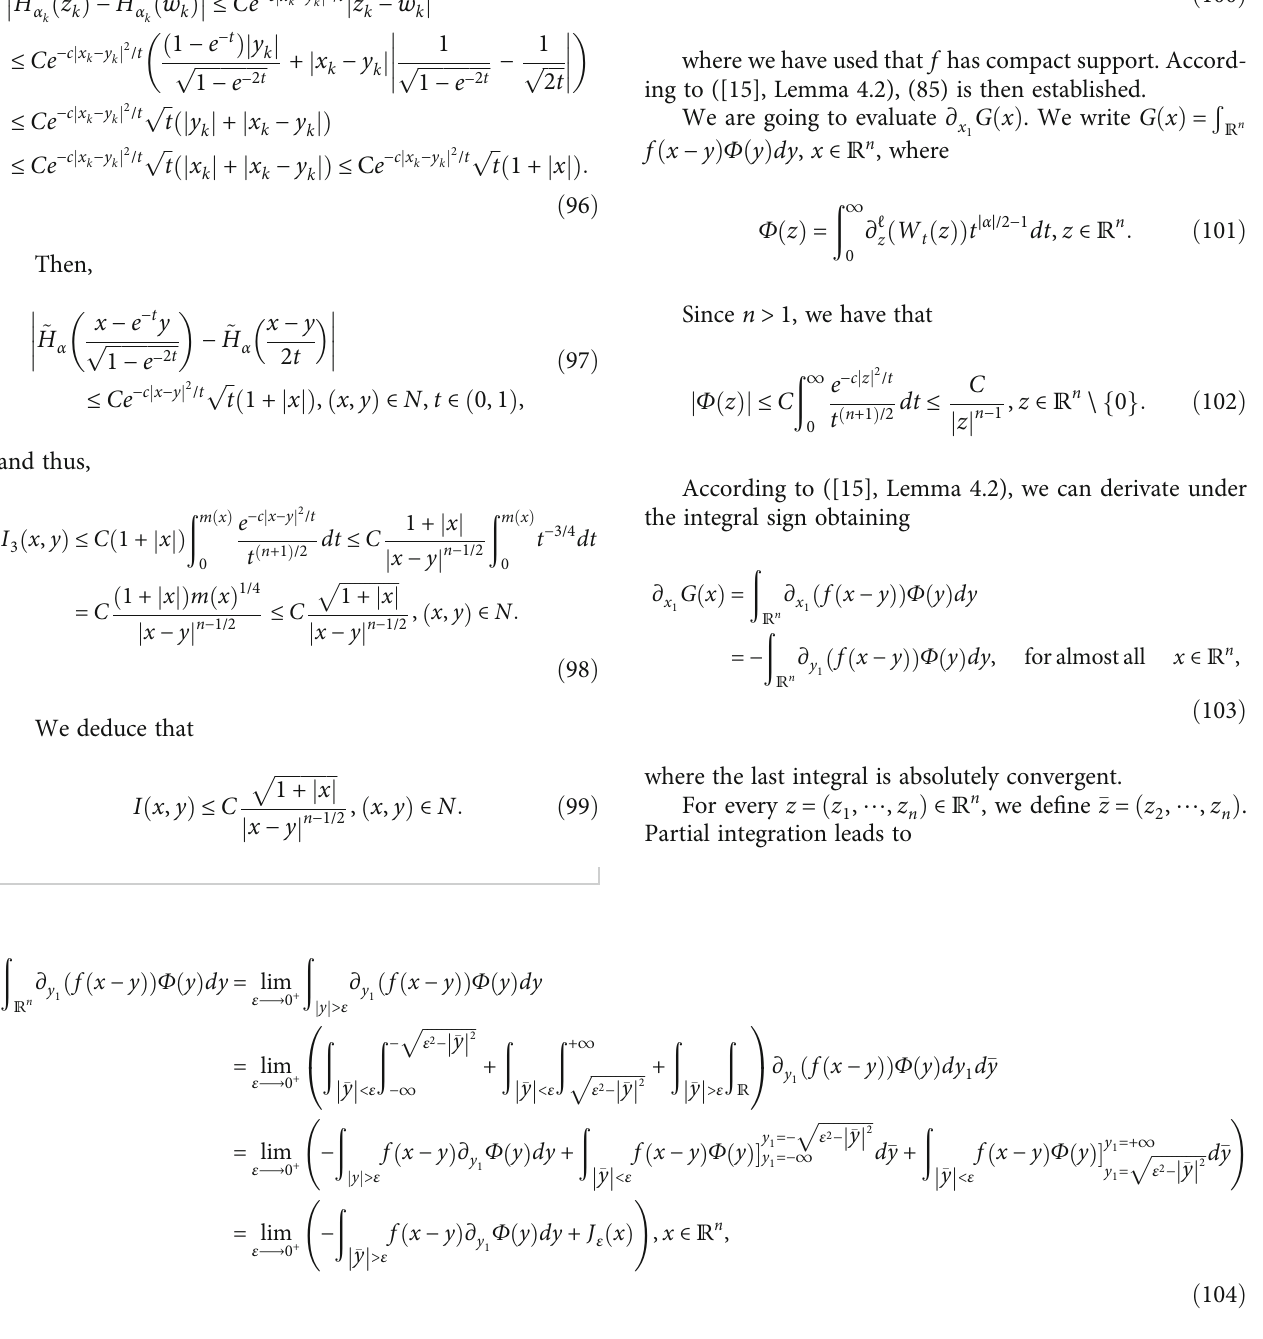
ffiffiffiffiffiffiffiffiffiffiffi p ε 2 − (cid:2) y j j 2